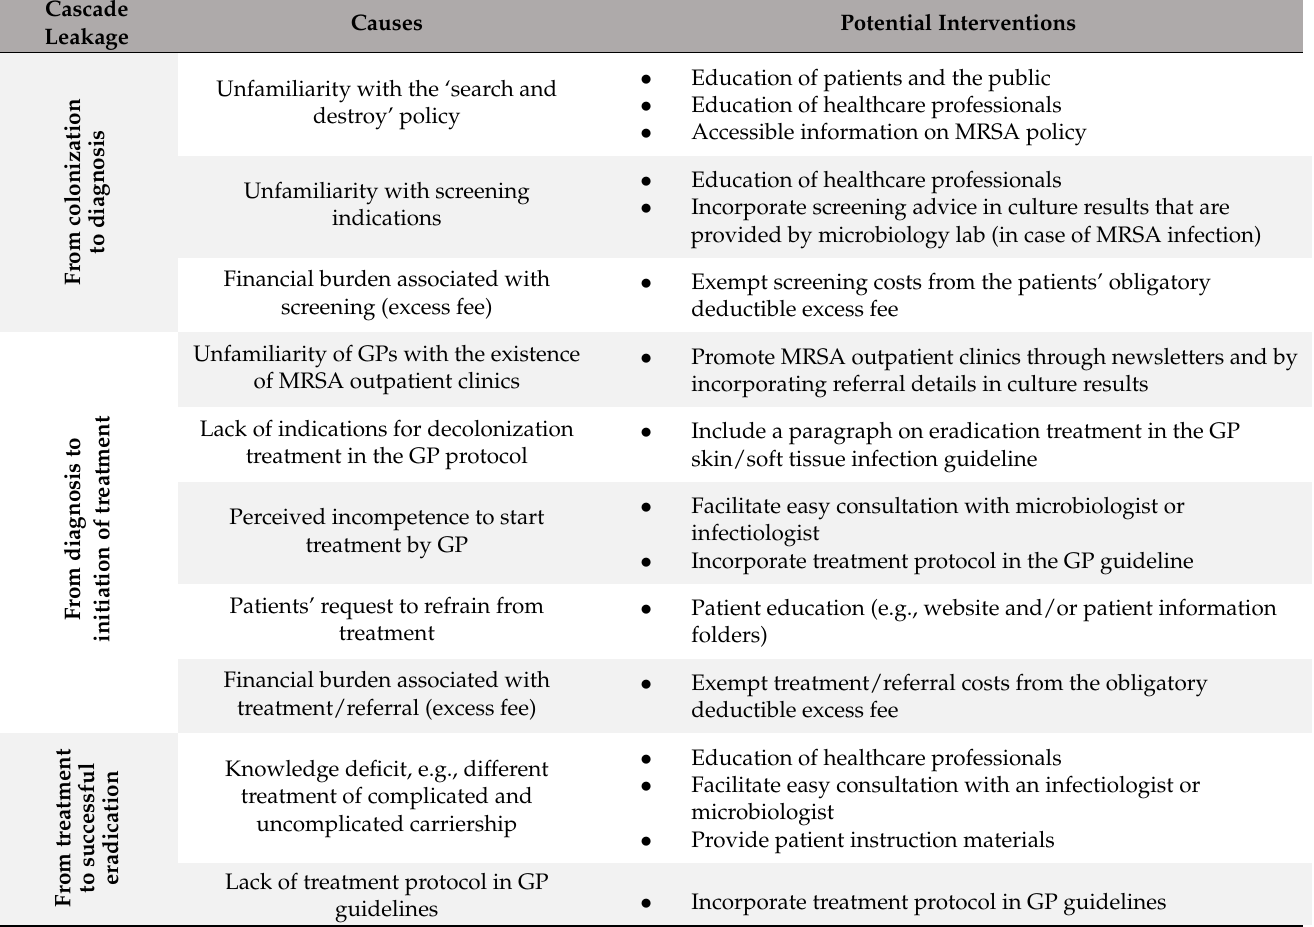
Table 3. Leakages in cascade of MRSA decolonization care and possible